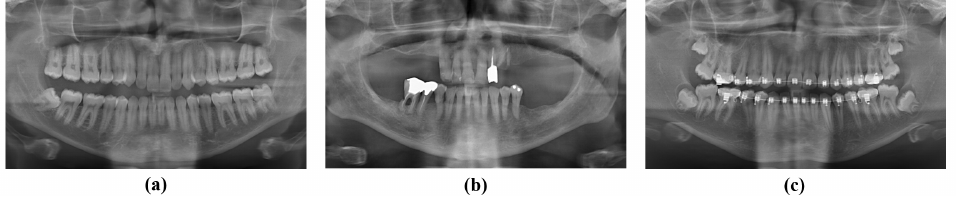
Figure 1. Examples of panoramic radiographic images. ( a ) image with 28 teeth, ( b ) image with restoration, and ( c ) image with dental appliance.